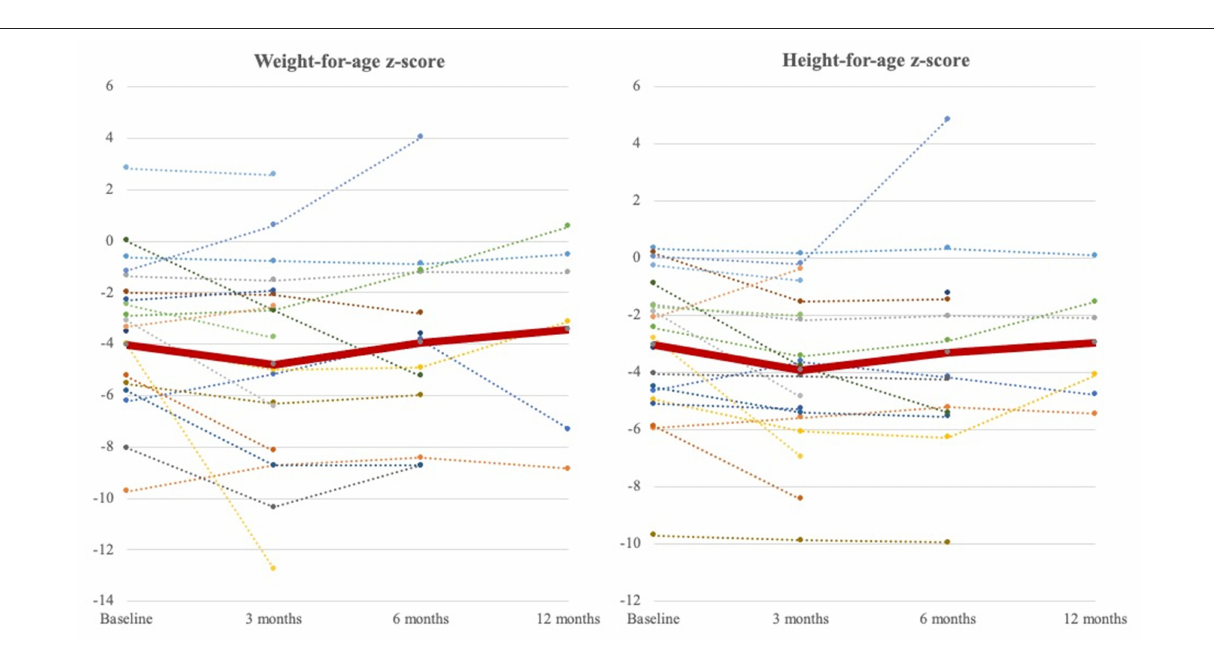
NE tube replacements were required in a long-term group (1.31 ± 1.93 vs. 0.17 ± 0.43, p < 0.001).